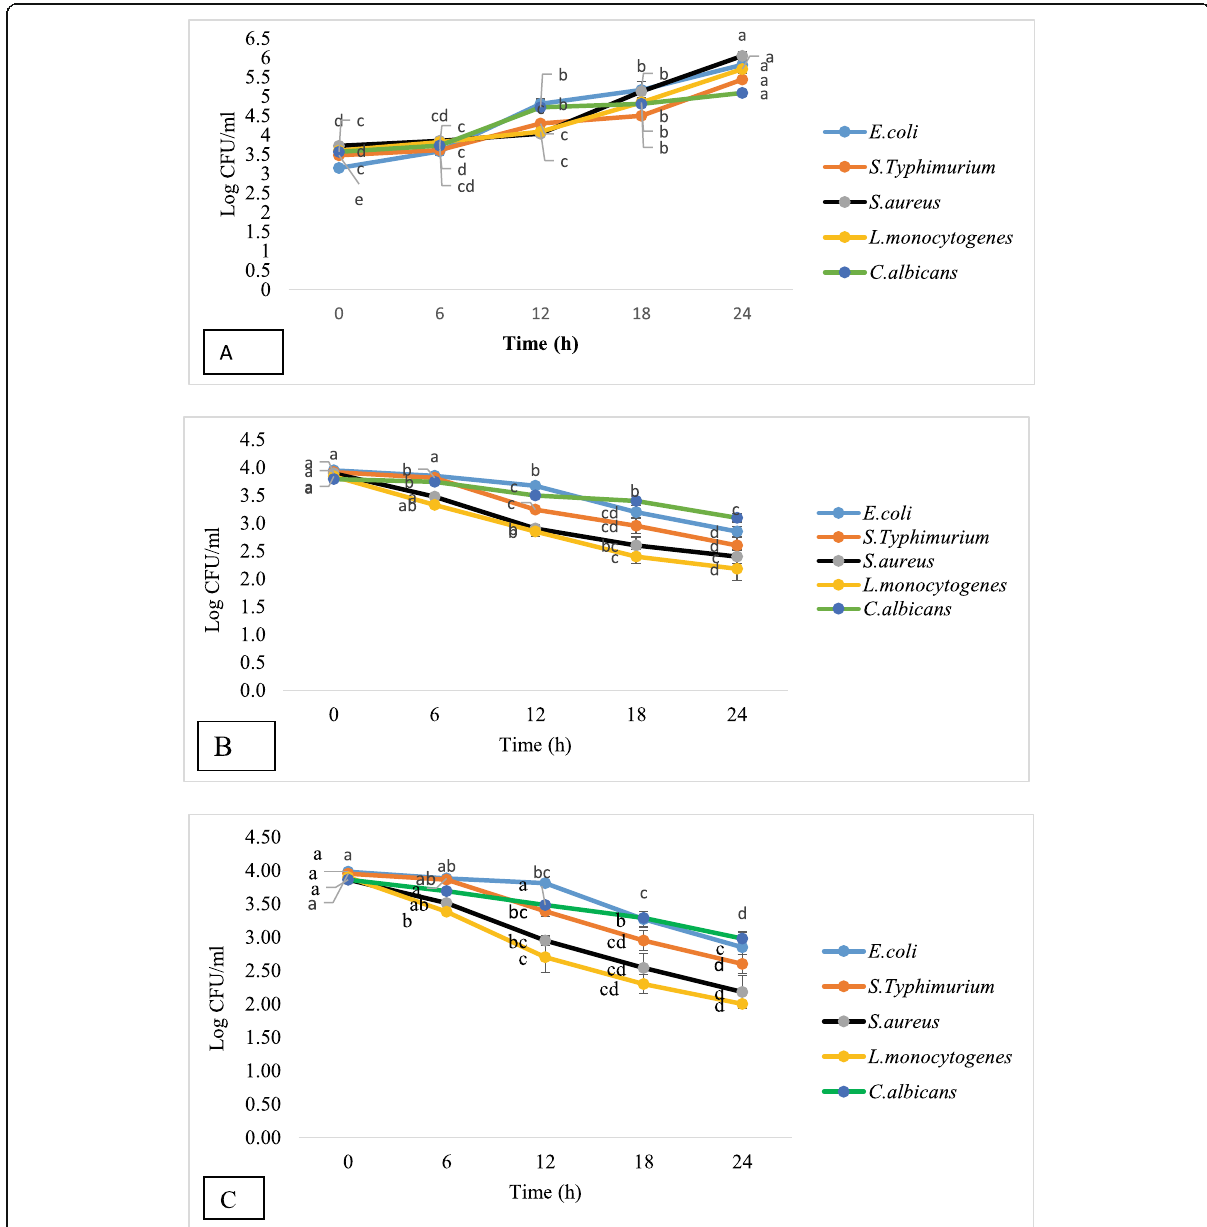
Fig. 5 Growth potential of pathogens in borde ( A ), grawa ( B ), and tej ( C ) beverages. The growth potential of E. coli, S. typhimurium , S. aureus , L. monocytogenes , and C. albicans in the three beverages was assessed within 24 h by drawing samples at an interval of 6 h. The growth or no growth of these pathogens was determined having cultured the drawn samples on the pathogens ’ respective media, incubated at 37 °C, and counted viable cells which latter expressed in Log CFU/ml. The mean ± standard is presented and the statistical analysis was determined using one-way ANOVA with Tukey post hoc test. Different letters in superscript along a column indicate presence of significant difference ( p < 0.05), while the same letters indicate absence of significant difference ( p >